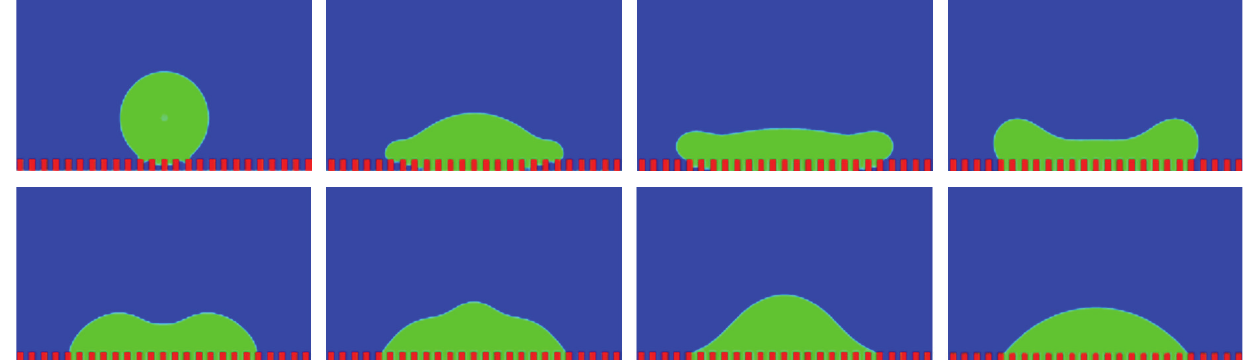
Figure 4: The dynamic behaviors of droplet impacting on hydrophilic surface (CA = 42.5 ∘ ).